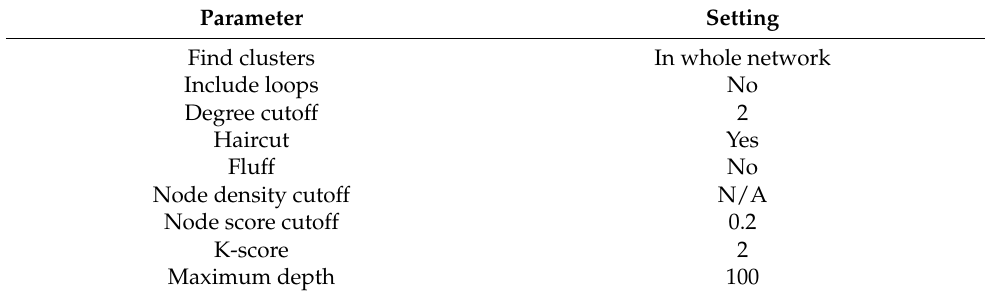
Table 2. MCODE settings for clustering